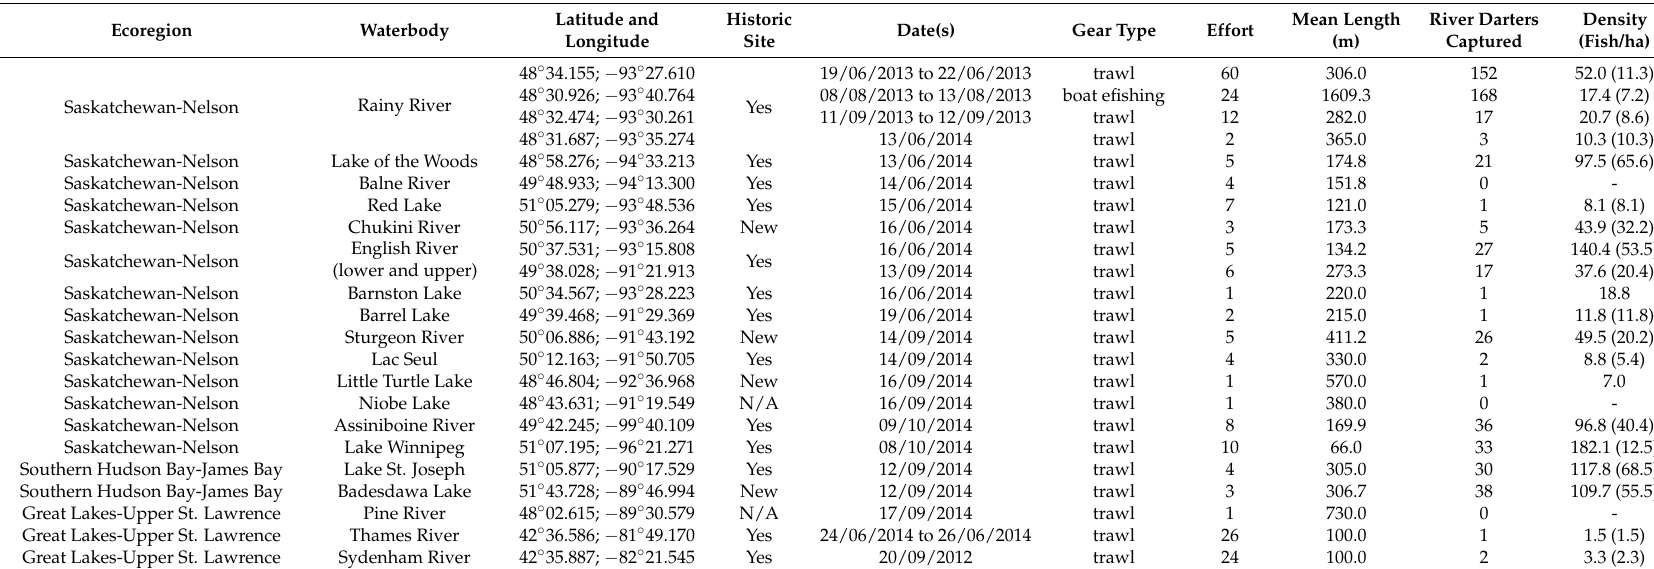
Table 2. Sampling site and date, ecoregion, gear type, effort (number of trawls or electrofishing [efishing] transects), the number of individuals captured, and mean density ( ± standard error) from recent DFO-led targeted River Darter surveys. Whether River Darters were previously found at that site is also